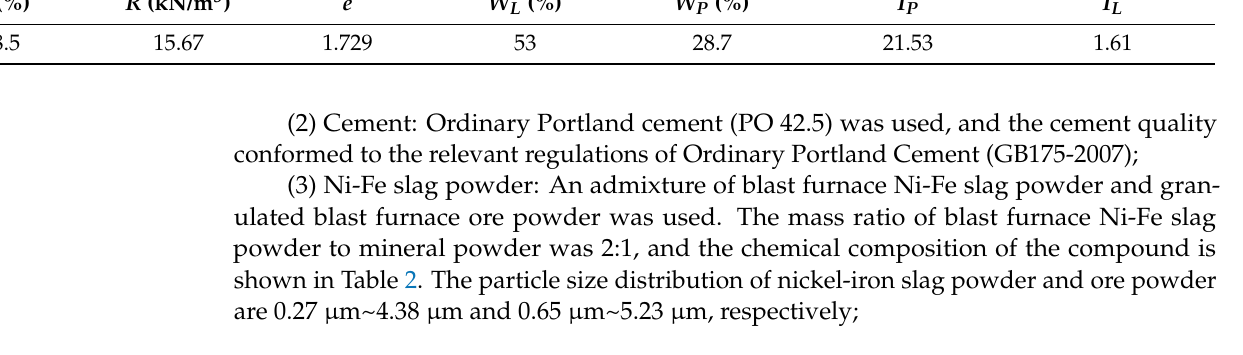
Table 2. Chemical Composition of